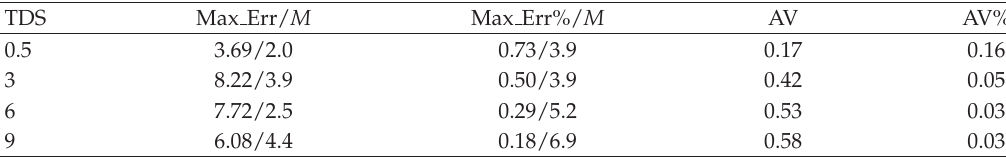
Table 6: Summary of the SVD results for the CO-8